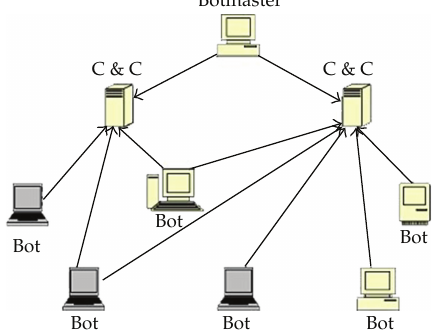
Figure 1: Centralized botnet (cid:5) 18 (cid:6) .